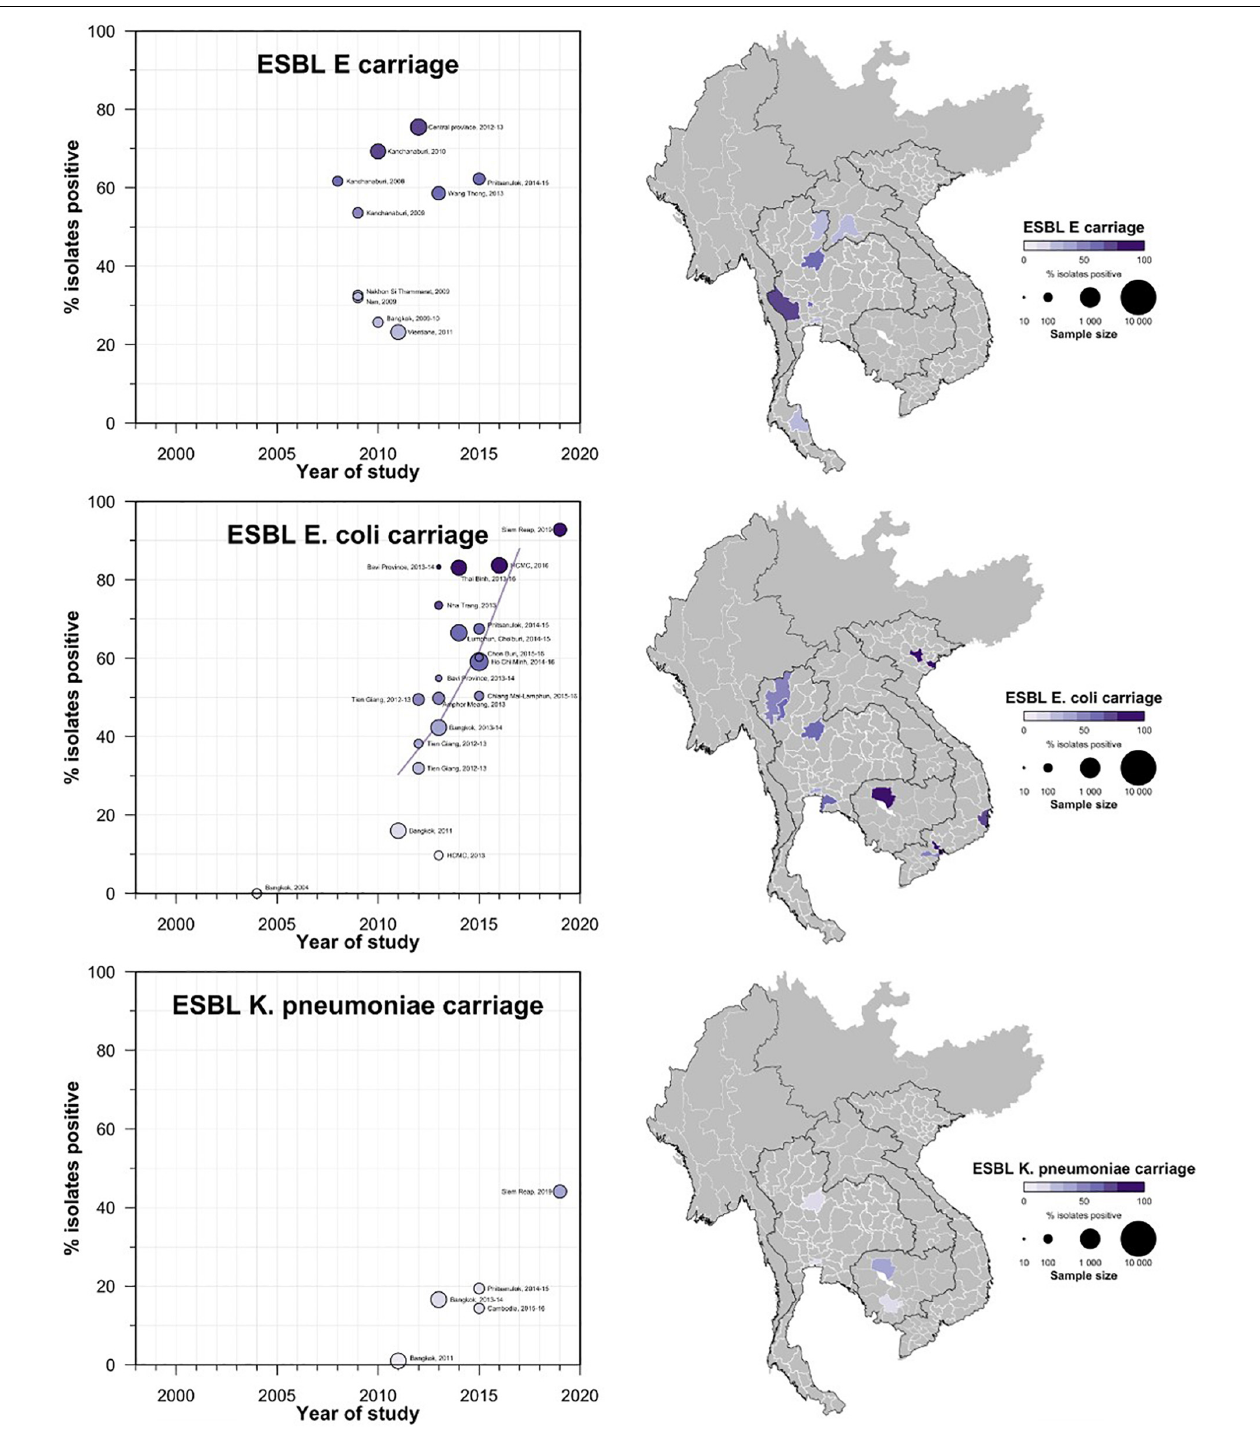
FIGURE 6 | Carriage ESBL-E, Ec, and Kp prevalence proportion in GMS. Observed ESBL prevalences, presented as proportions, of E, Ec, and Kp isolated from stool or rectal swab specimens in the Greater Mekong Subregion over time and across geographical regions. The smallest unit of geographical regions considered, demarcated by white lines on the map, is the first-order administrative units or provinces. The size of the points corresponds to the sample size of the studies, and broken rings represent studies that do not report a sample size. Darker points and regions indicate a higher prevalence of ESBL Ec, and province with no observed data are shaded gray. If multiple studies were available for a province, the highest value is presented. For studies across multiple provinces, the ESBL-E, Ec, and Kp overall prevalences are presented for all the named provinces.